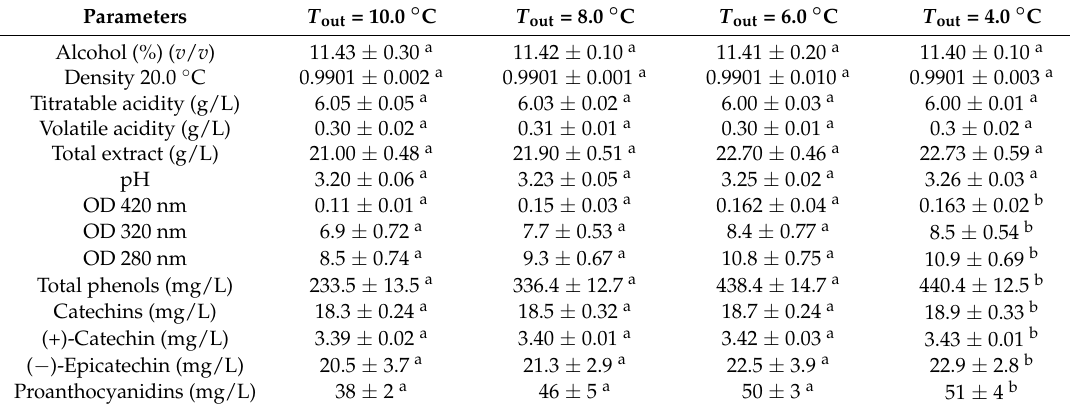
Table 4. Analytical determinations performed on wines made from grapes subjected to cryomaceration processes at different final temperatures (Chardonnay